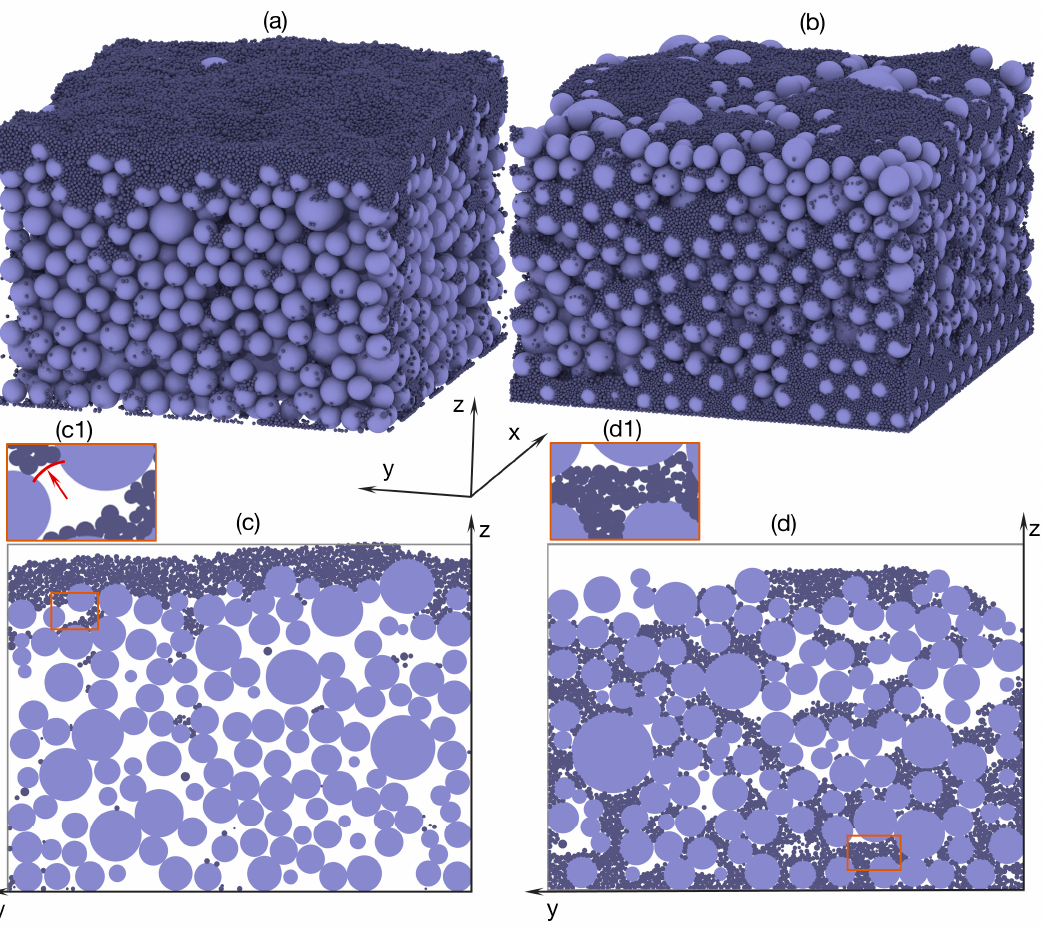
Figure 8. Bed structure of filled gravel at final computational time step. ( a ) Bridging and ( b ) percolation and of the middle x-axis cross-section. ( c ) Bridging and ( d ) percolation.